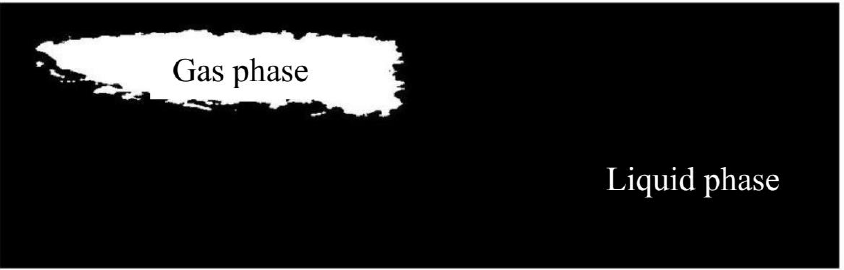
Figure 7. Image after image processing when the pressure is 0.2 MPa and tilted upward by 10°. (2) Probability density function graph.